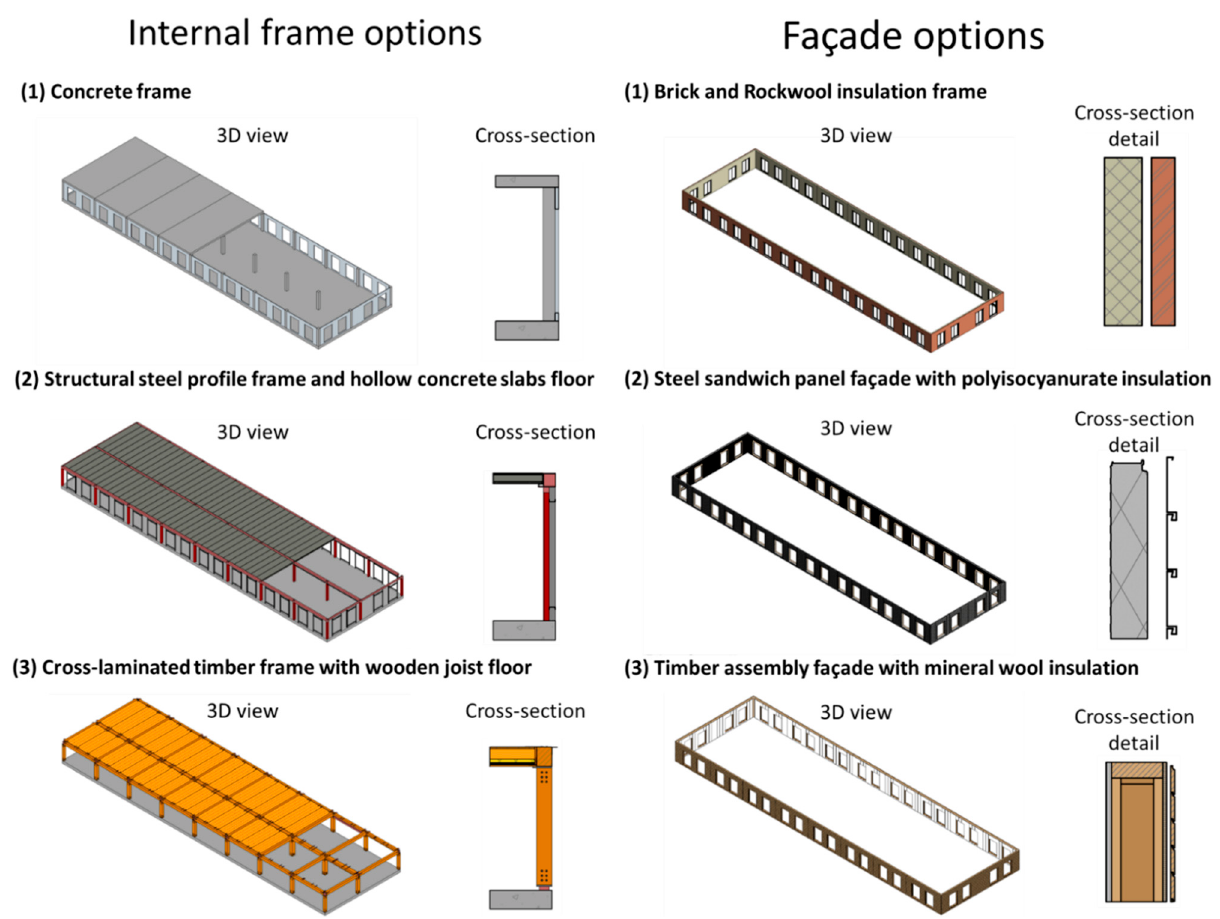
Figure 3. Material options for the façade and structural frame of the demonstrator case provided by Heijmans.